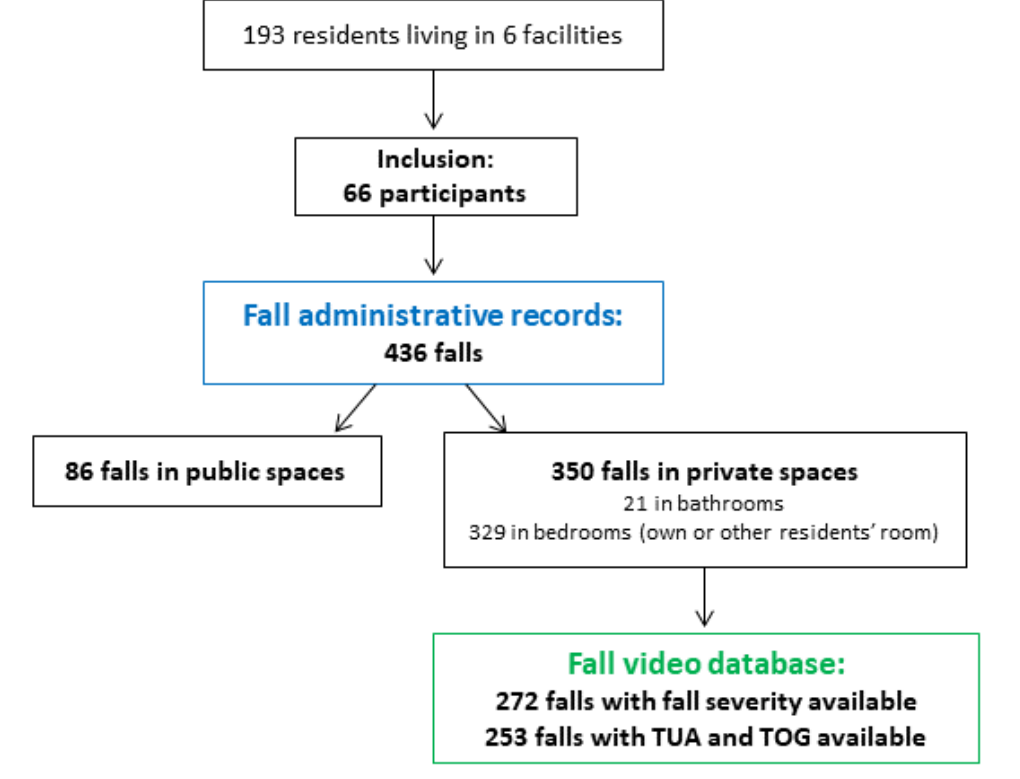
Figure 2. Flow chart showing inclusions and fall databases. TOG: Time On the Ground; TUA: Time Until staff Assistance